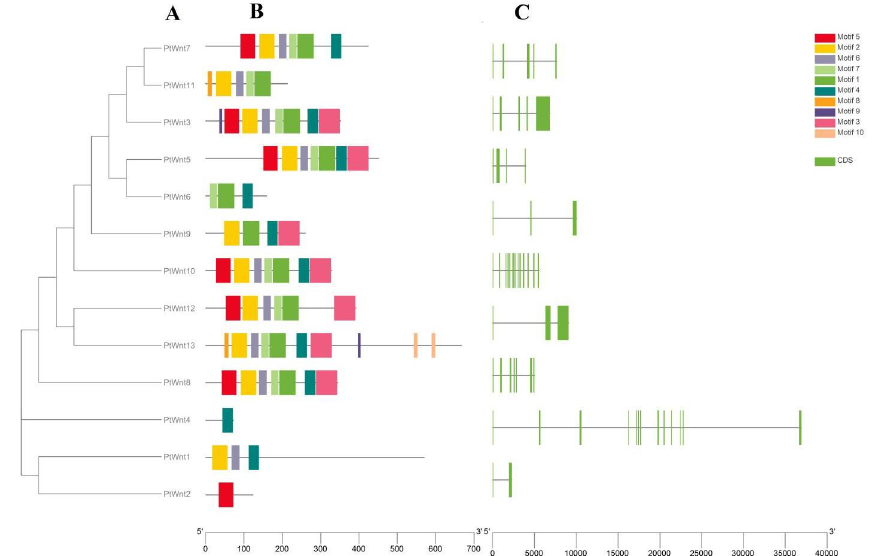
Figure 3. Unrooted neighbor-joining phylogenetic tree, architecture of conserved motifs, and gene structure of the PtWnt gene family. ( A ) The phylogenetic tree was generated based on the sequences of PtWnt proteins; ( B ) conserved motif analysis of PtWnt proteins. Different colored boxes represent different types of motifs; ( C ) coding sequence (CDS) structure of PtWnt gene